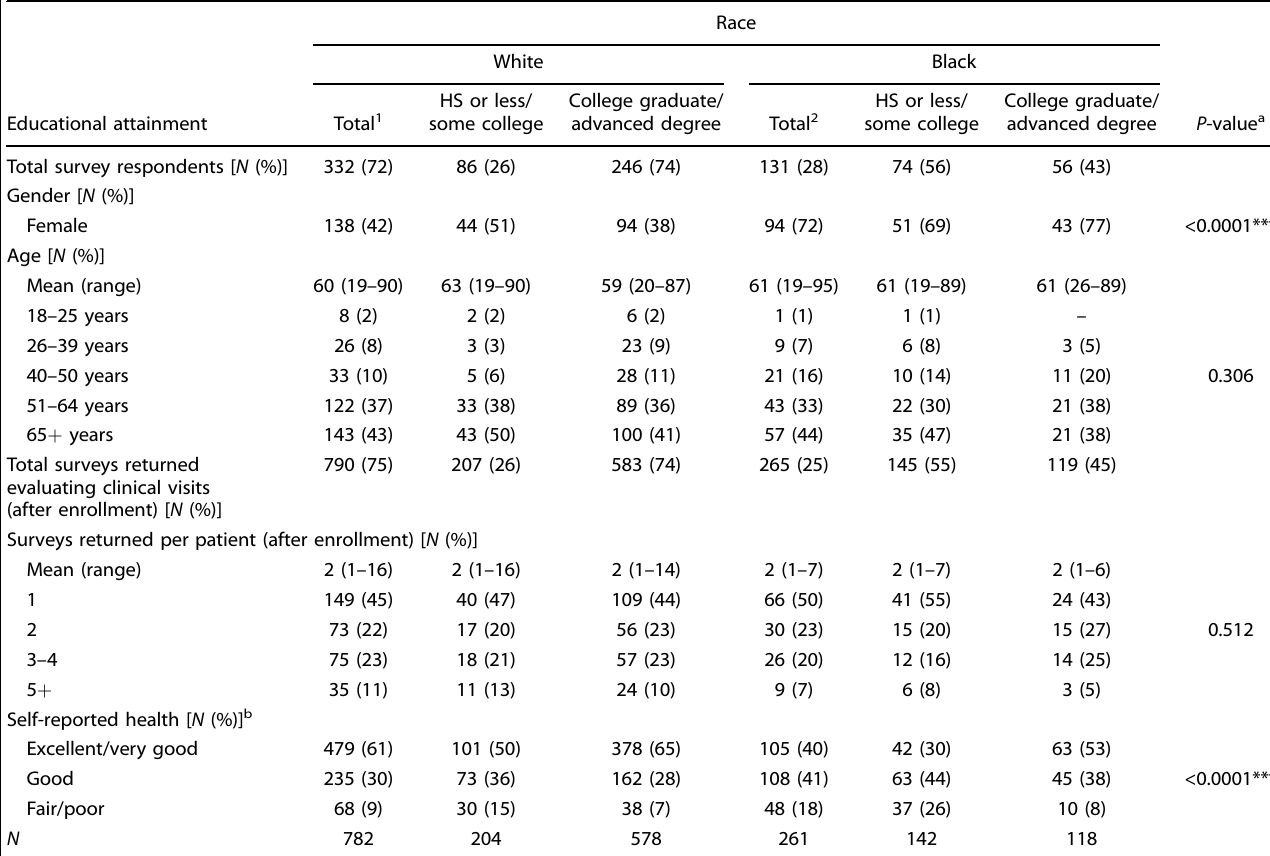
Table 1. Patient characteristics by self-reported race and educational attainment ( N =